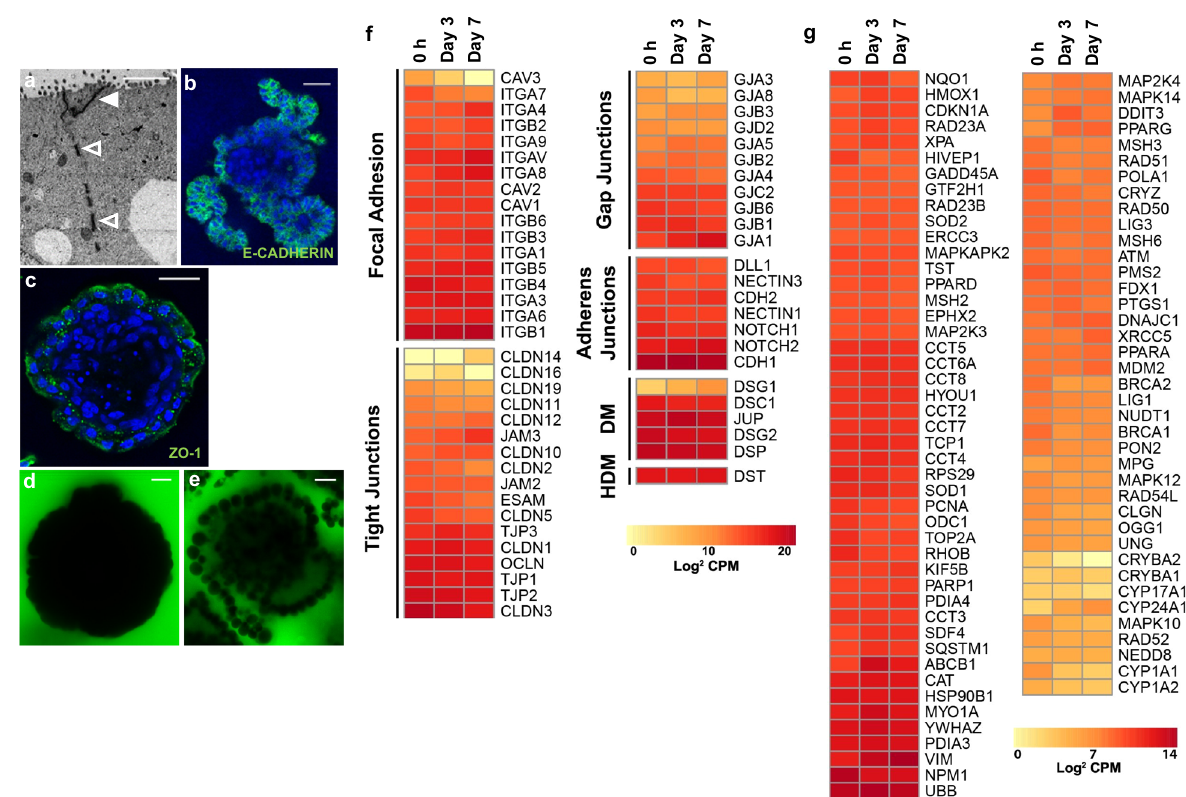
Fig. 5 Chicken enteroids display epithelial barrier integrity, express cell junction related genes and minimally alter stress-related genes. a Transmission electron microscopy of a chicken enteroid (7 days of culture) demonstrates tight junctions (closed arrow) and desmosomes (open arrows). b – c Confocal images of chicken enteroids (2 days of culture) stained for b E-cadherin (green, adherens junctions) and c ZO-1 (green, tight junctions) and counterstained with DAPI (blue). d – e Confocal images of chicken enteroids (2 days of culture) immersed in FITC-dextran 4 kDa showing epithelial barrier integrity in d untreated and e loss of barrier integrity after EDTA-treatment. Scale bar: a 2 µ m, b – e 20 µ m. Images are representative of data from at least 3 independent cultures each containing 2 – 3 embryos. f – g Expression of f epithelial cell junction-related genes and g cell stress-related genes in freshly isolated villi (0 h) and chicken enteroids at 3 and 7 days of culture was compared by RNA sequencing analysis. f Heat maps show the expression levels (log2 counts per million reads) of a range of epithelial cell junction-related genes. DM: desmosomes HD: hemi-desmosomes. g Heat map shows minimal change in expression levels of a range of mammalian cell stress-related genes over 7 days of culture. RNA sequencing data is representative of 3 independent experiments, comprising 2 technical replicates, each containing 3